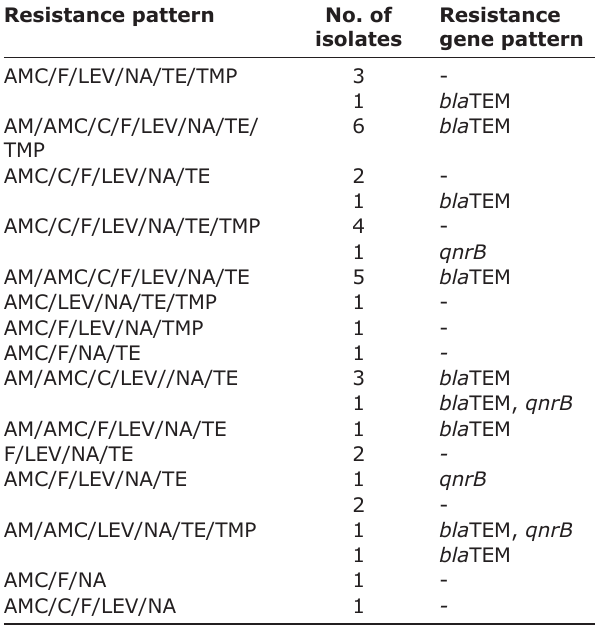
Table-4: Antibiotic resistance patterns of MDR Salmonella isolates of broilers. Resistance pattern No. of isolates